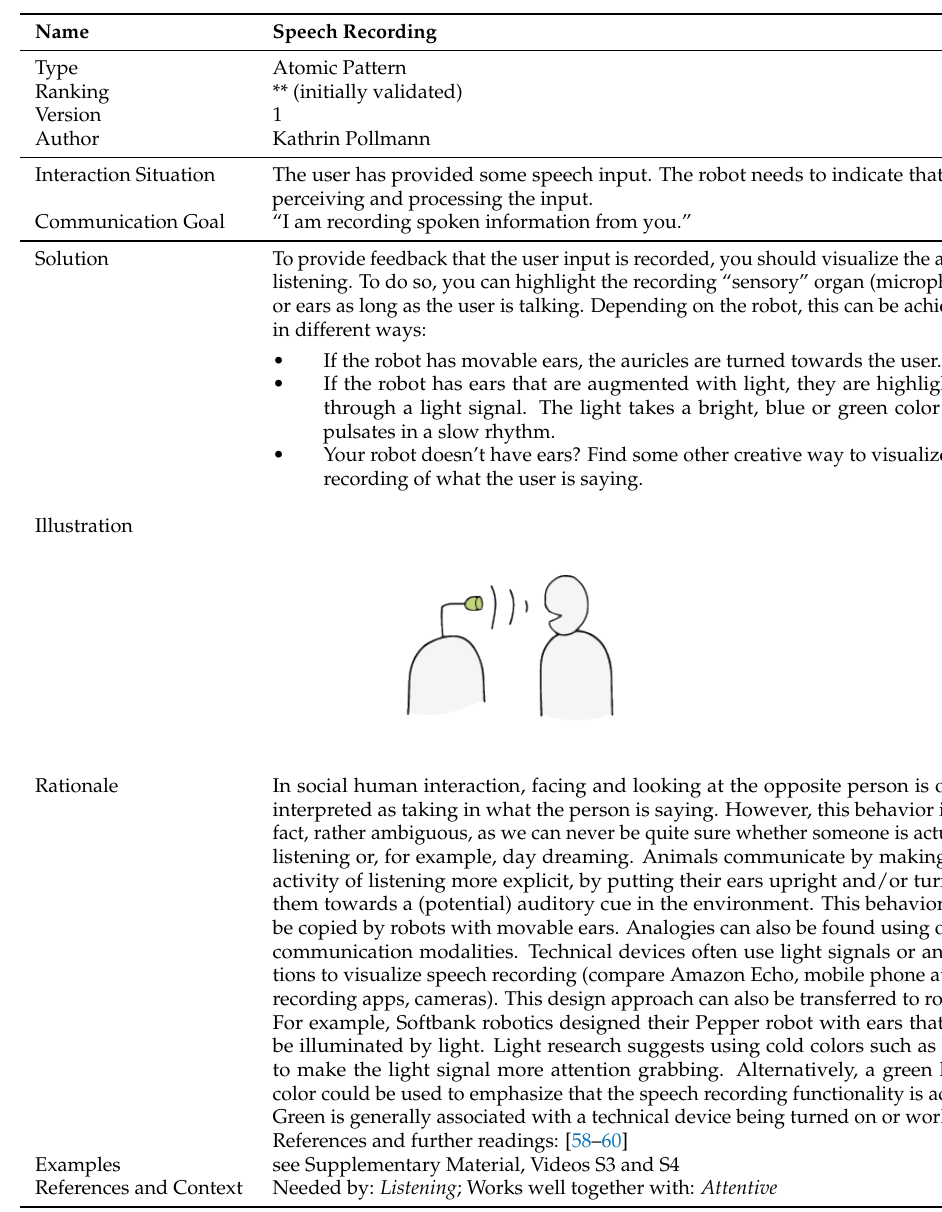
Table A2. Formal documentation of the pattern for the robot action “record user